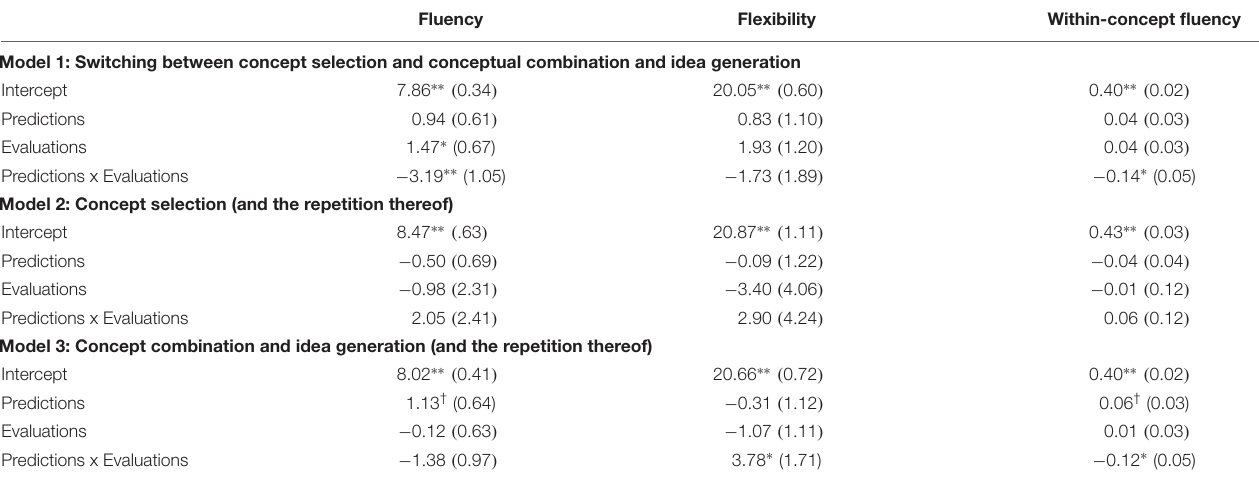
TABLE 5 | Results of the generalized linear mixed model analysis for the correlations between predictions and evaluations with fluency, flexibility, and within-concept fluency. Fluency Flexibility Within-concept